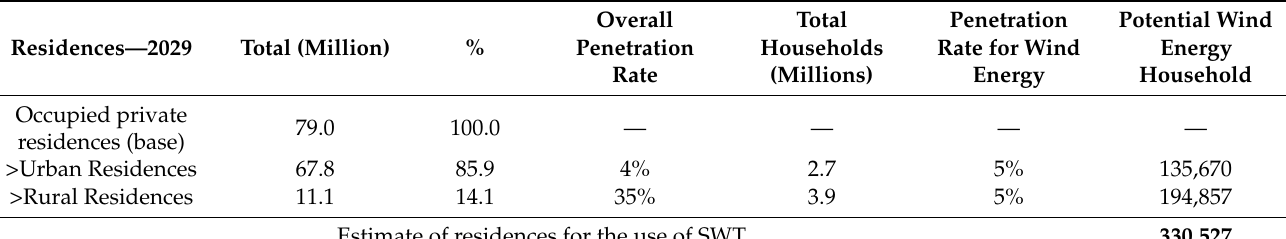
Table 6. The potential residential market for small wind turbines in